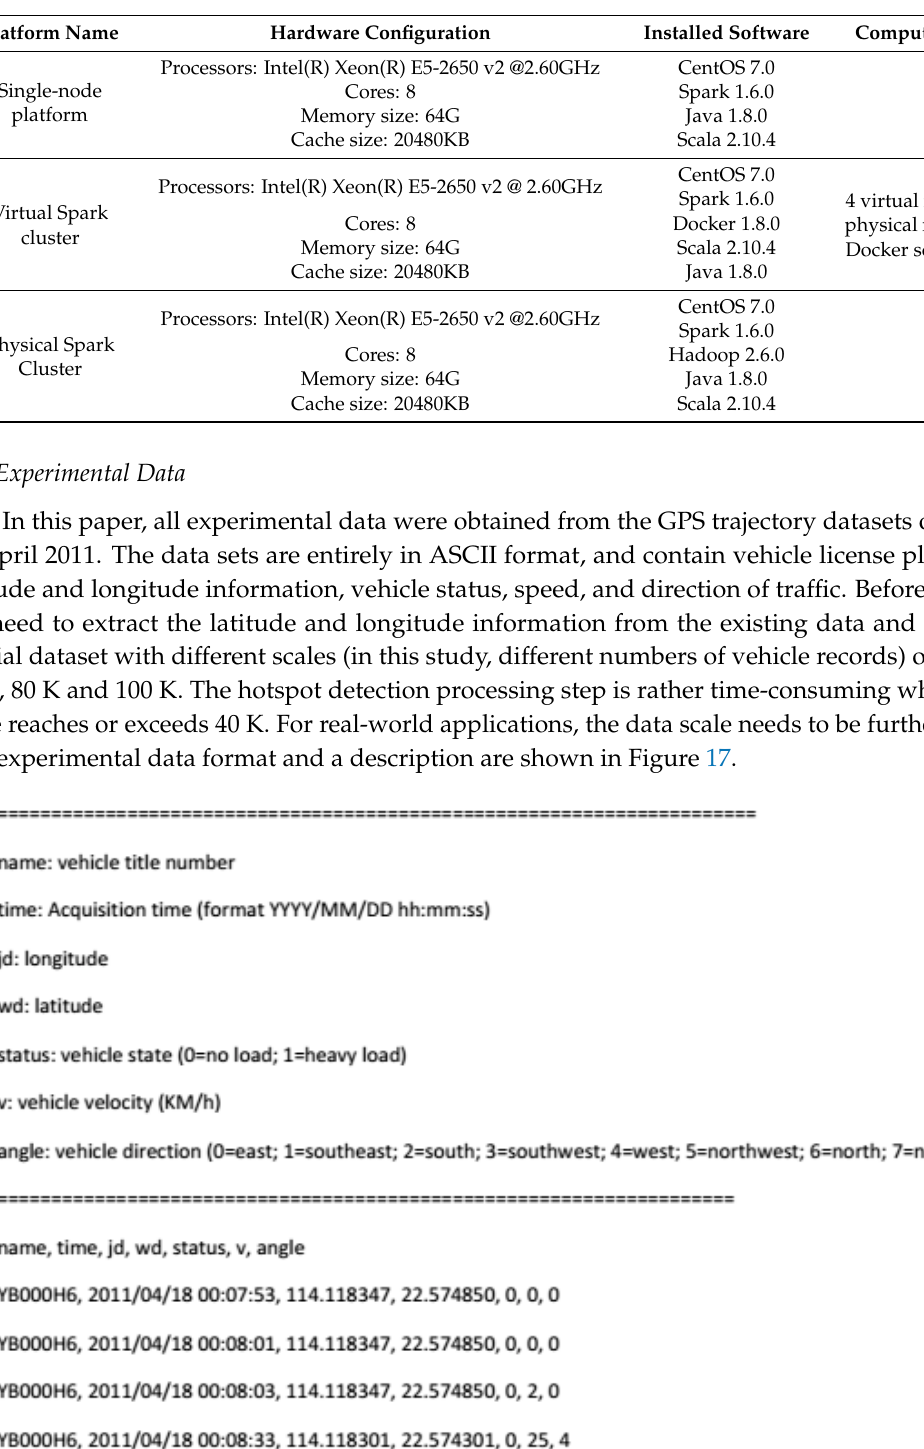
Figure 17. Description and data format of the GPS trajectory data.